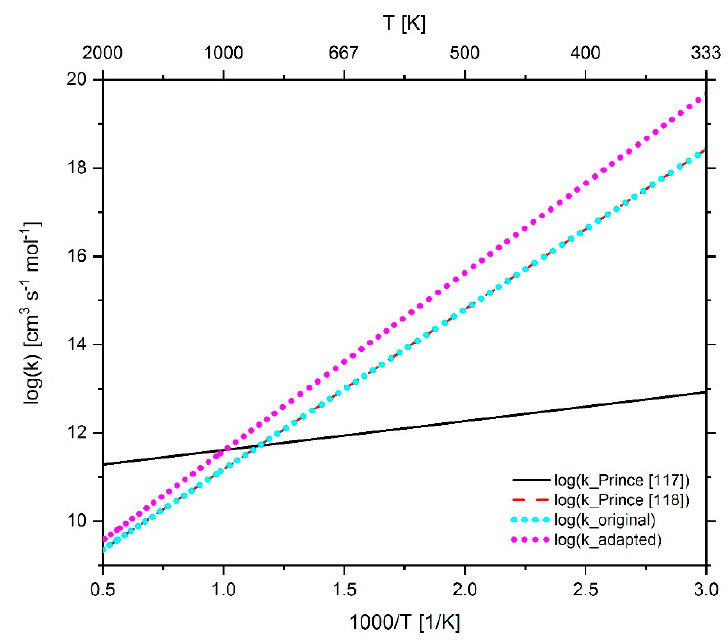
Figure 28. Comparison of the reaction rate coefficient of reaction 299 ( n -C 7 -QOOH + O 2 ↔ n -C 7 -OQOOH + OH) before and after adaptation as well as the rate coefficients published by Prince et al. [117,118].